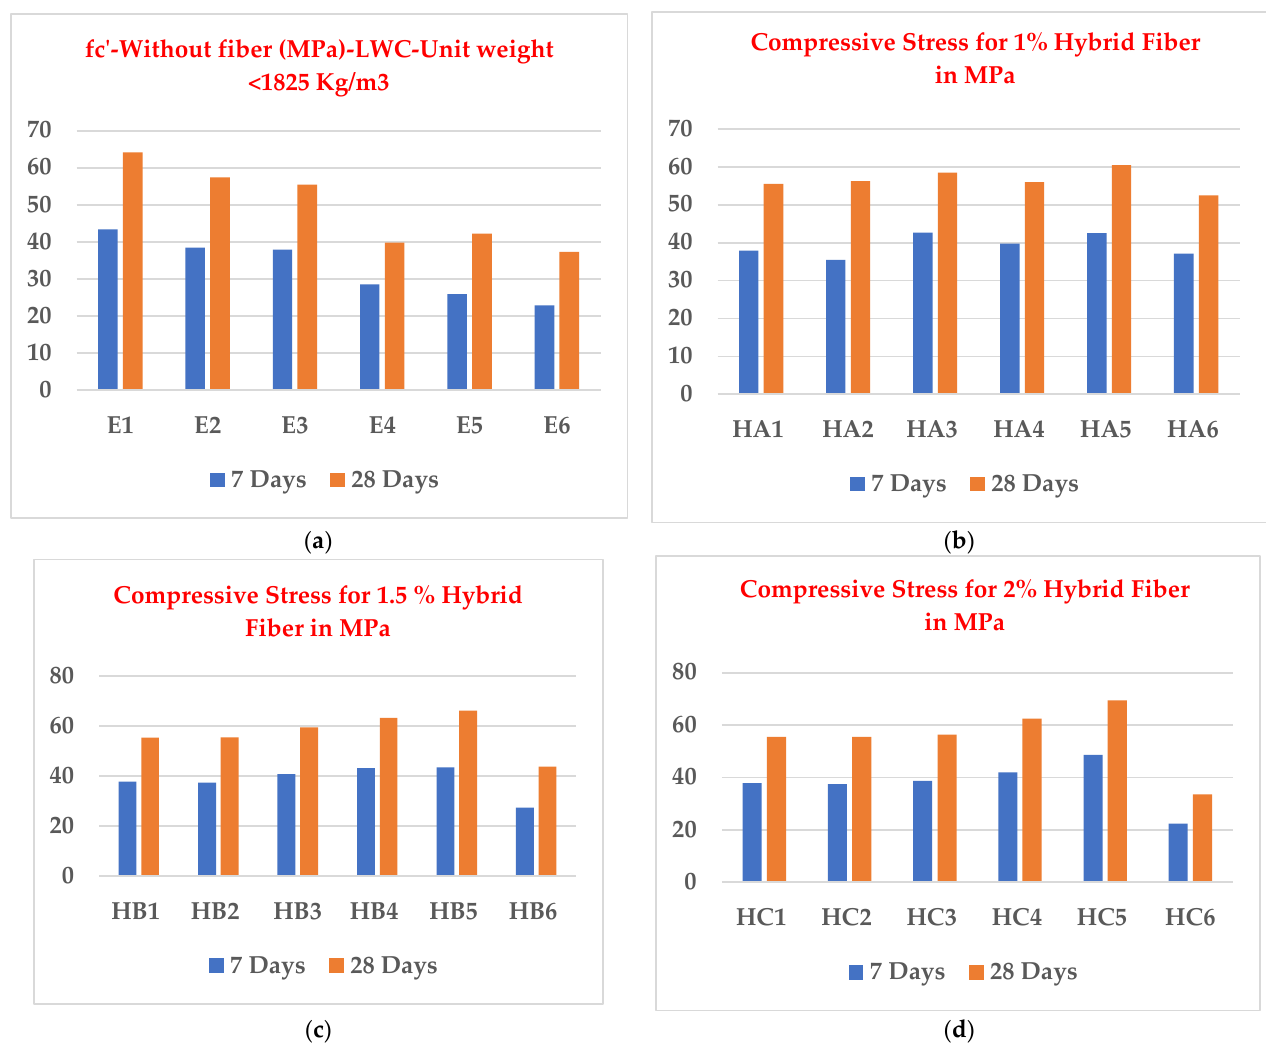
Figure 5. Compressive strength of concrete with different fiber contents.